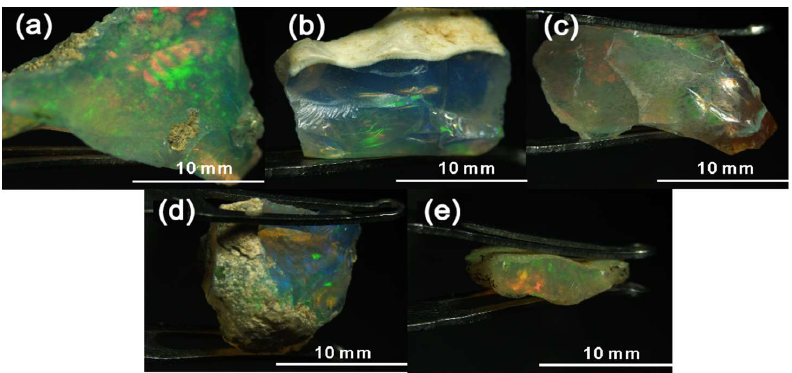
Figure 2. Rough samples with surrounding rock. ( a ) Opal-07; ( b ) Opal-08; ( c ) Opal-09; ( d ) Opal-10; ( e ) Opal-11.